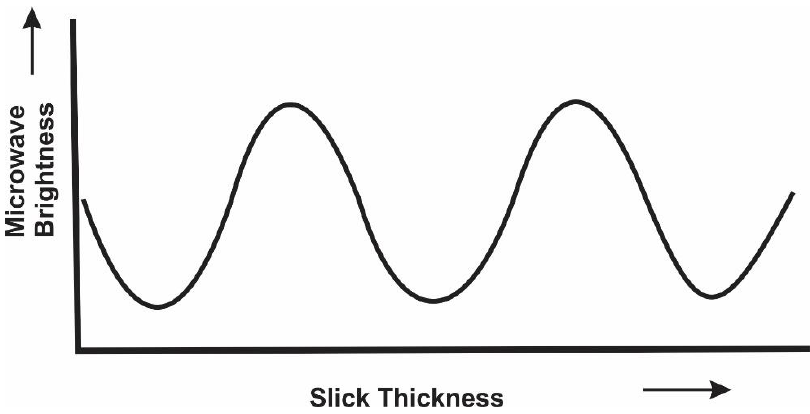
Figure 2. The cyclic relationship between microwave brightness and oil thickness.